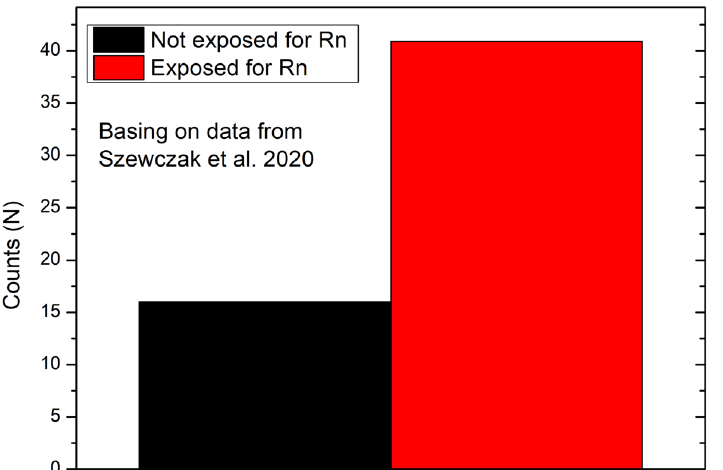
Figure 9. Averaged number of counts registered in liquid scintillation detector for biochar exposed and not exposed for radon in laboratory condition (basing on the data presented in 25